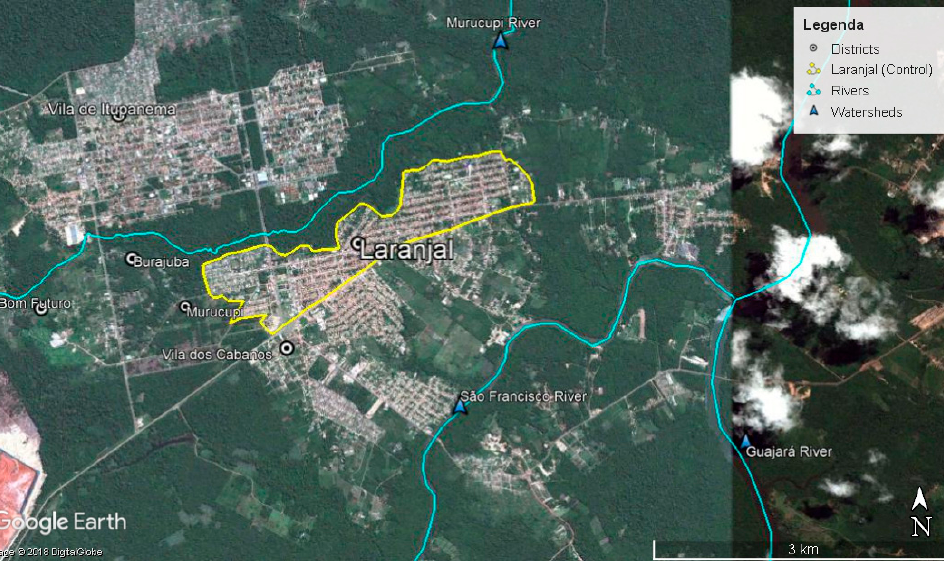
Figure A2. Location of the district of Dom Manuel (DMN), 2012. Source: Google Earth, 2017.